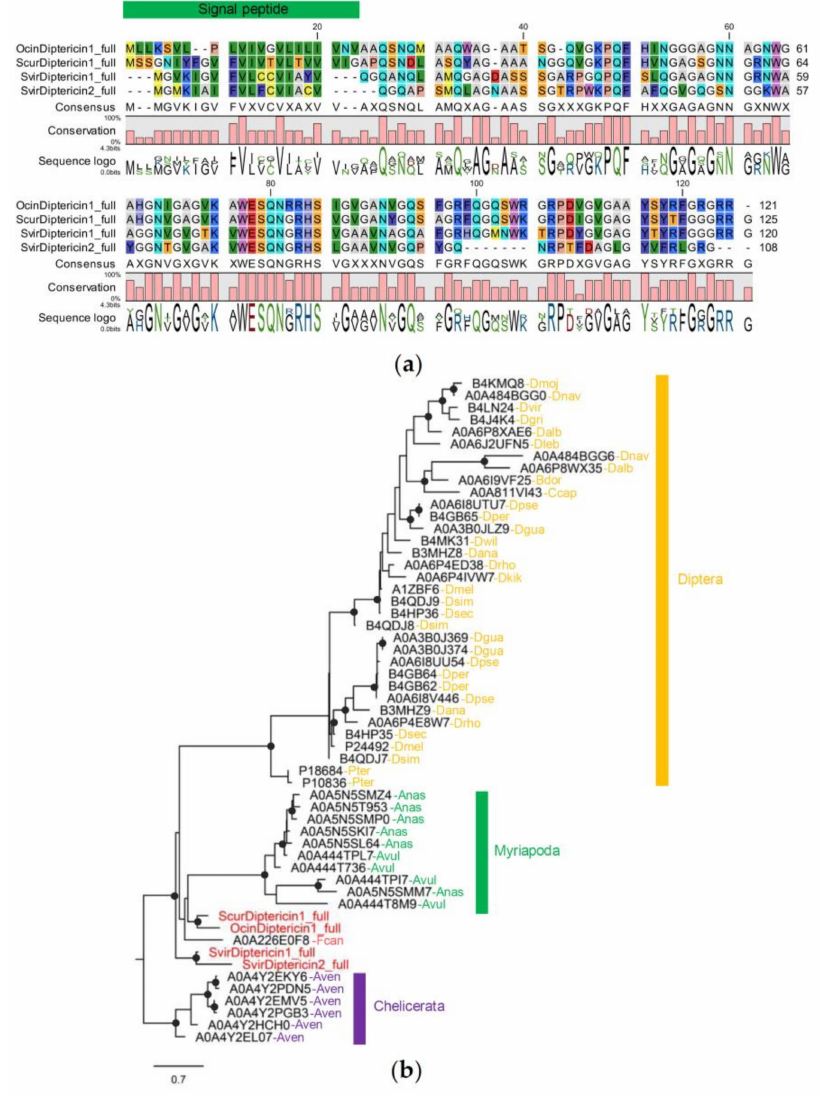
Figure 5. Sequence alignment and phylogenetic relationships of collembola Diptericin: ( a ) protein alignment; ( b ) Phylogenetic tree of arthropod diptericins. Branch sup- ports (aLRT) higher than 0.9 were indicated with black dots on tree nodes (Abbrevi- ation: Ocin = O. cincta , Scur = Si. curviseta , Svir = Sm. viridis Dmoj = Drosophila mojavensis , Dnav = D. navojoa , Dvir = D. virilis , Dgri = D. grimshawi , Dalb = D. albomicans , Dleb = D. lebanonensis , Bdor = Bactrocera dorsalis , Ccap = Ceratitis capitata , Dpse = D. pseudoobscura , Dper = D. persimilis , Dgua = D. guanche , Dwil = D. willistoni , Dana = D. ananassae , Drho = D. rhopaloa , Dkik = D. kikkawai , Dmel = D. melanogaster , Dsim = D. simulans , Dsec = D. sechellia , Pter = Protophormia terraenovae , Anas = Armadillidium nasatum , Avul = A. vulgare , Aven = Araneus ventricosus